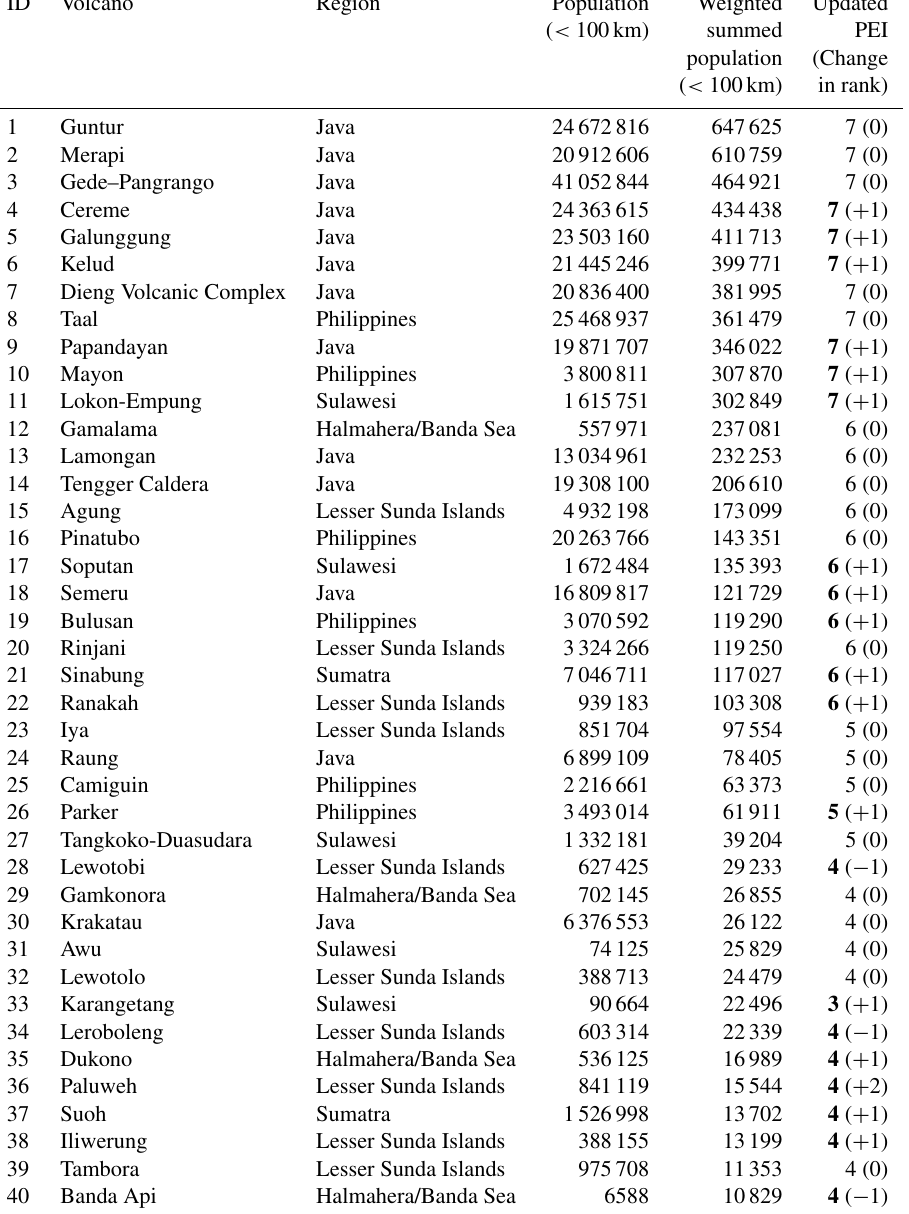
Table 2. Volcanoes considered for analysis in this study, the exposed and weighted summed population within 100km (LandScan 2018; Rose et al., 2019), and the updated PEI (and change in PEI from that calculated in Brown et al., 2015b). Those volcanoes with a change in PEI are shown in bold. See text for details on how the PEI was updated. Volcanoes are ordered by decreasing weighted summed population < 100km from the volcano. Volcano IDs are used in Fig.